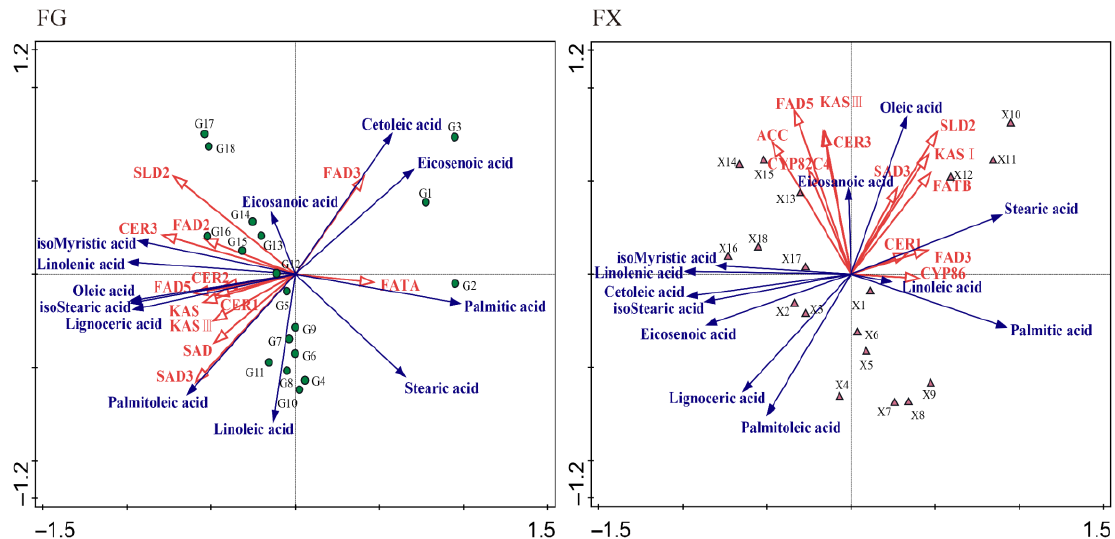
Figure 6. Redundancy analysis (RDA) of fatty acid composition for ( FG ) and ( FX ) samples under low temperature.